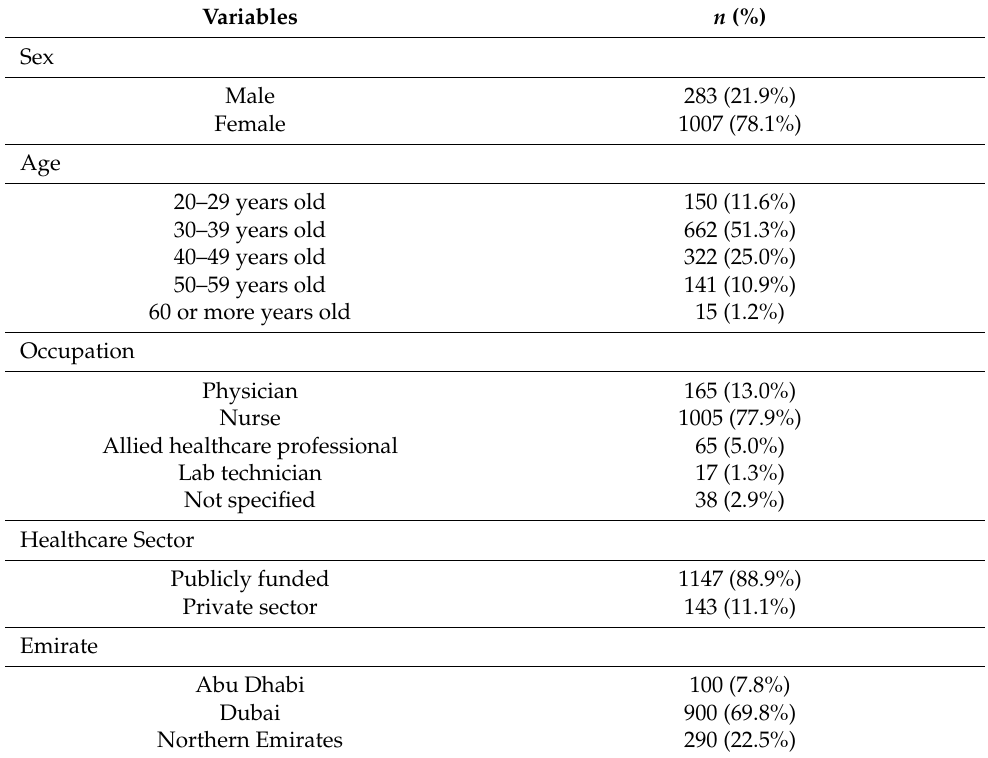
Table 1. Healthcare worker’s